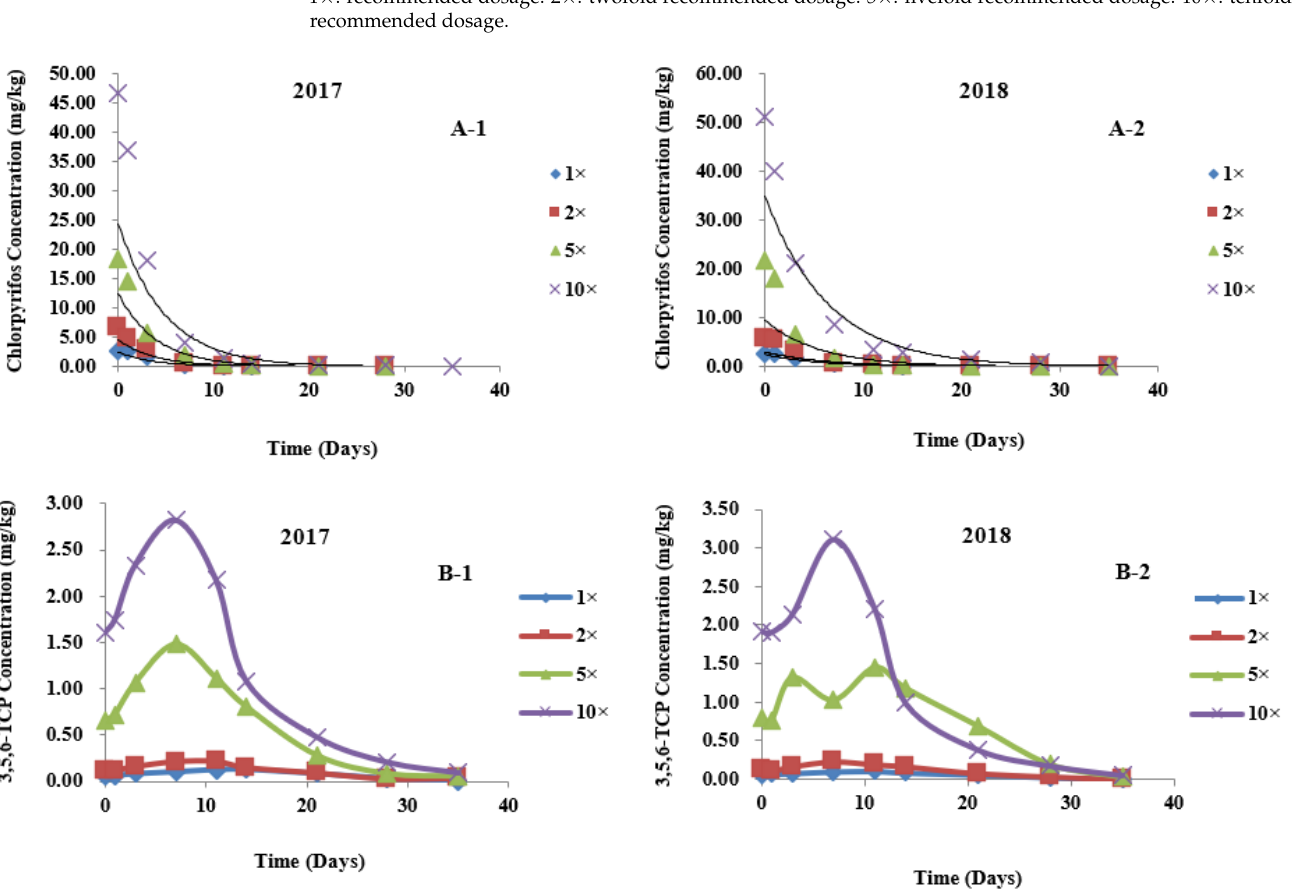
Figure 2. Degradation curves of chlorpyrifos and its metabolite 3,5,6-TCP at different applied dosages in wheat ears. ( A-1 ) Degradation curves of Chlorpyrifos at different applied dosages in wheat ears in 2017; ( A-2 ) Degradation curves of Chlorpyrifos at different applied dosages in wheat ears in 2018; ( B-1 ) Degradation curves of 3,5,6-TCP at different applied dosages in wheat ears